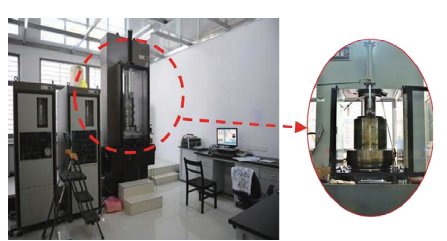
Figure 4: Experimental apparatus.